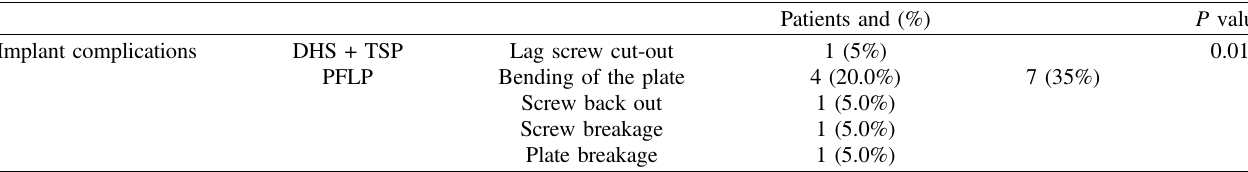
Table 2. Implant failure rate and types in both groups.